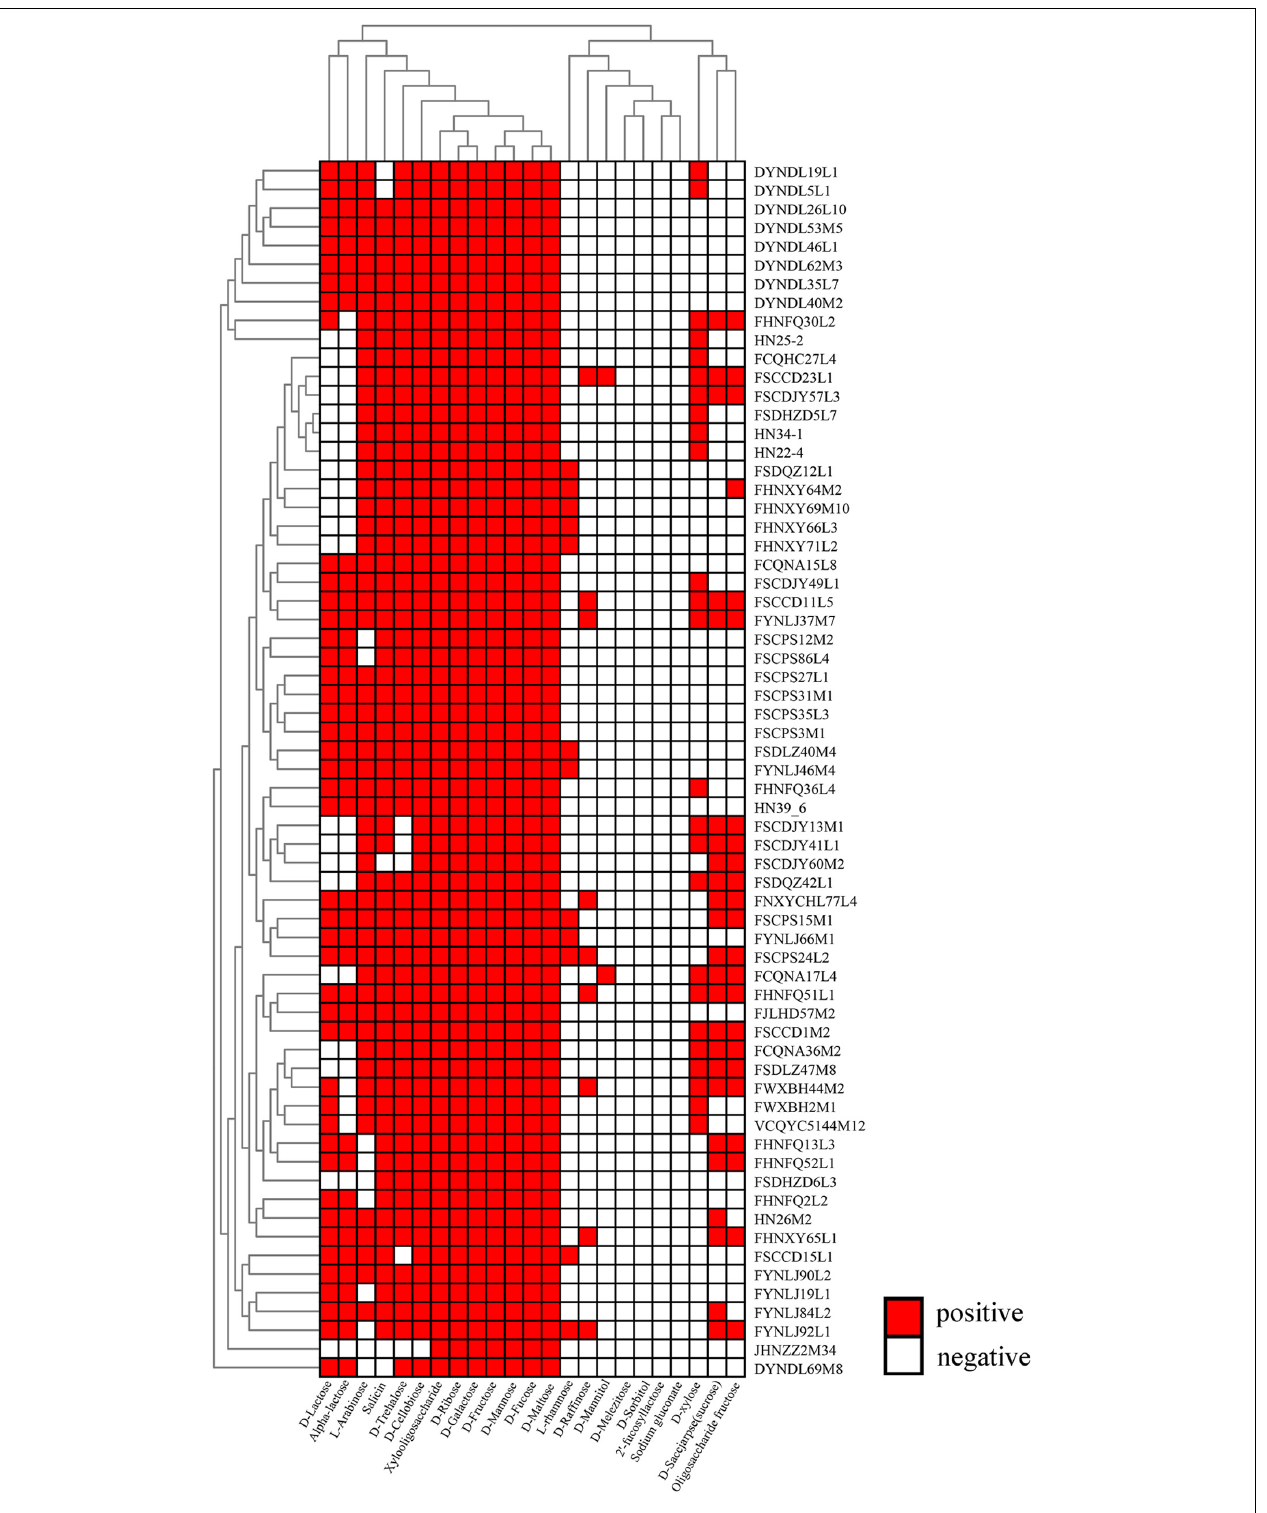
FIGURE 8 | Evaluation of carbohydrate utilization by P. pentosaceus strains. Heatmap showing the growth performance of P. pentosaceus strains on different carbon sources at 24 h. The vertical axis represents the genomes tested in this study which were clustered according to the phylogenetic tree. The horizontal axis represents 23 carbohydrates used in this test. The color scales represent the degree of P. pentosaceus utilizing carbohydrates with white squares (as in blank) represents the inability of strains to metabolize the corresponding sugar and red squares representing the ability of strains to metabolize the corresponding sugar.